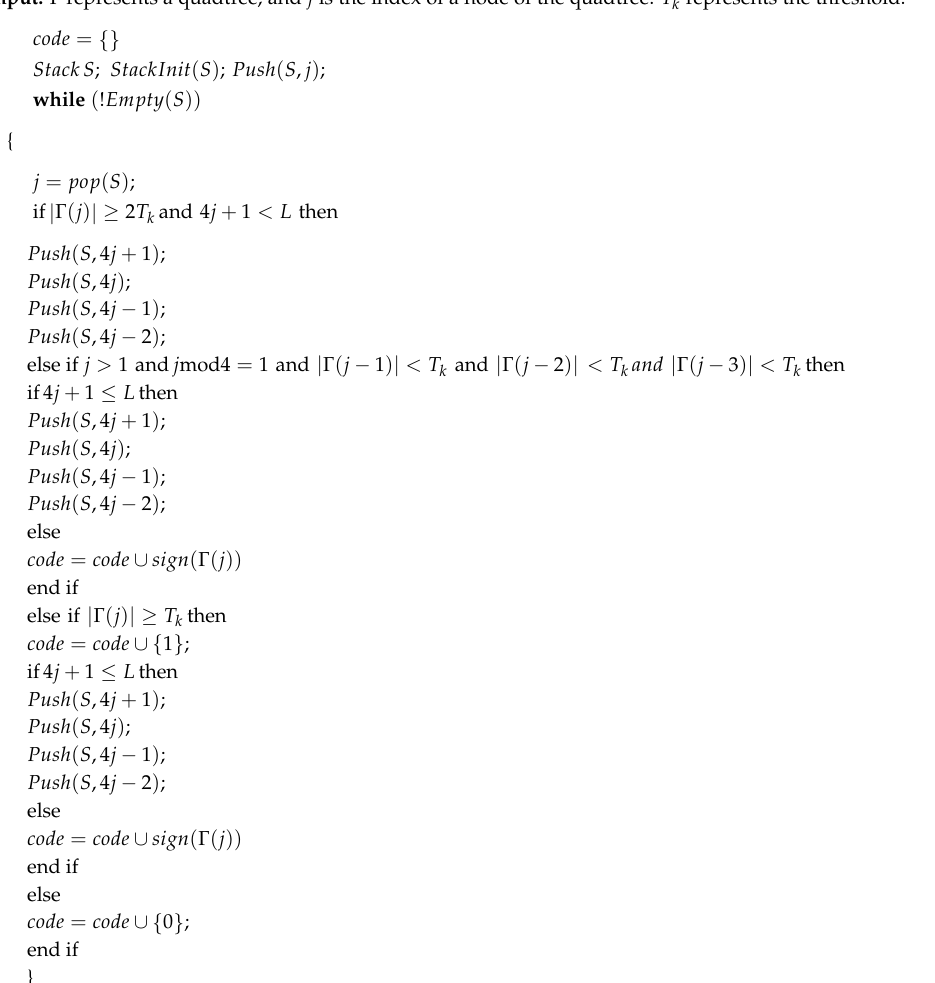
Algorithm 3. Function code = QC ( Γ , j , T k )